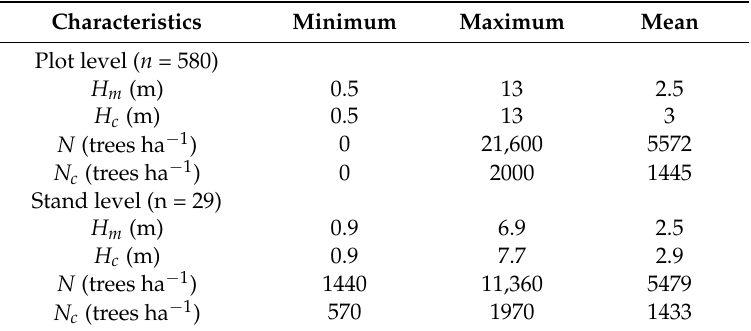
Table 1. Summary statistics for the field-plot